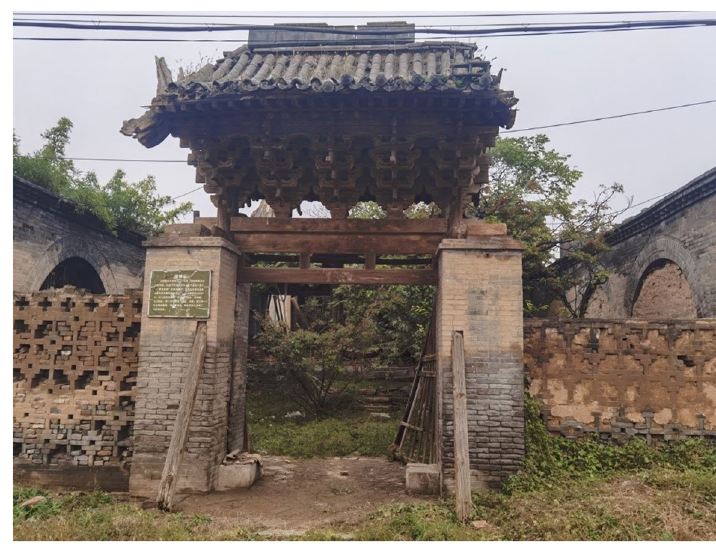
Fig. 14 Yuanshen Temple after the flood (Source: the